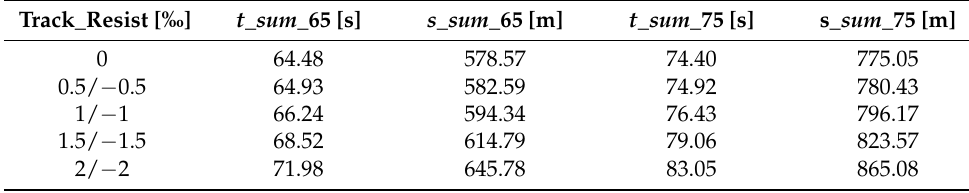
Table 6. Time and length of braking distance up to stopping of both train